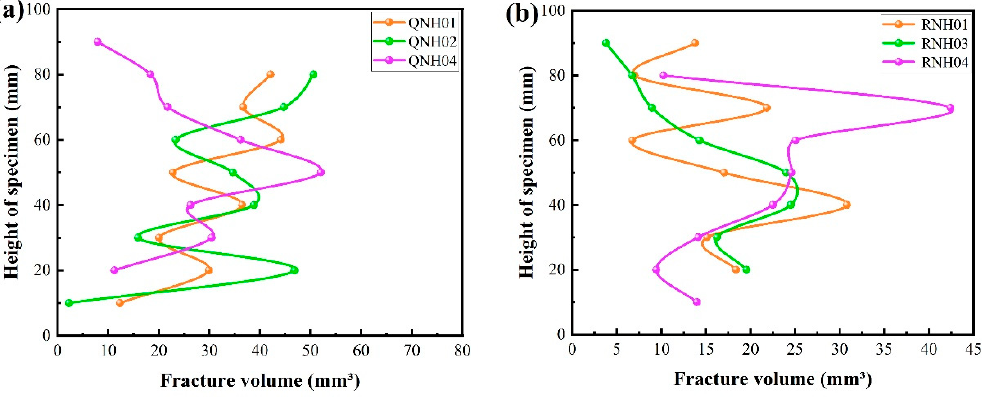
Figure 12. Distribution of fracture volume along with the height of the specimen. ( a ) The strongly welded tuffs. ( b ) The weakly welded tuffs.